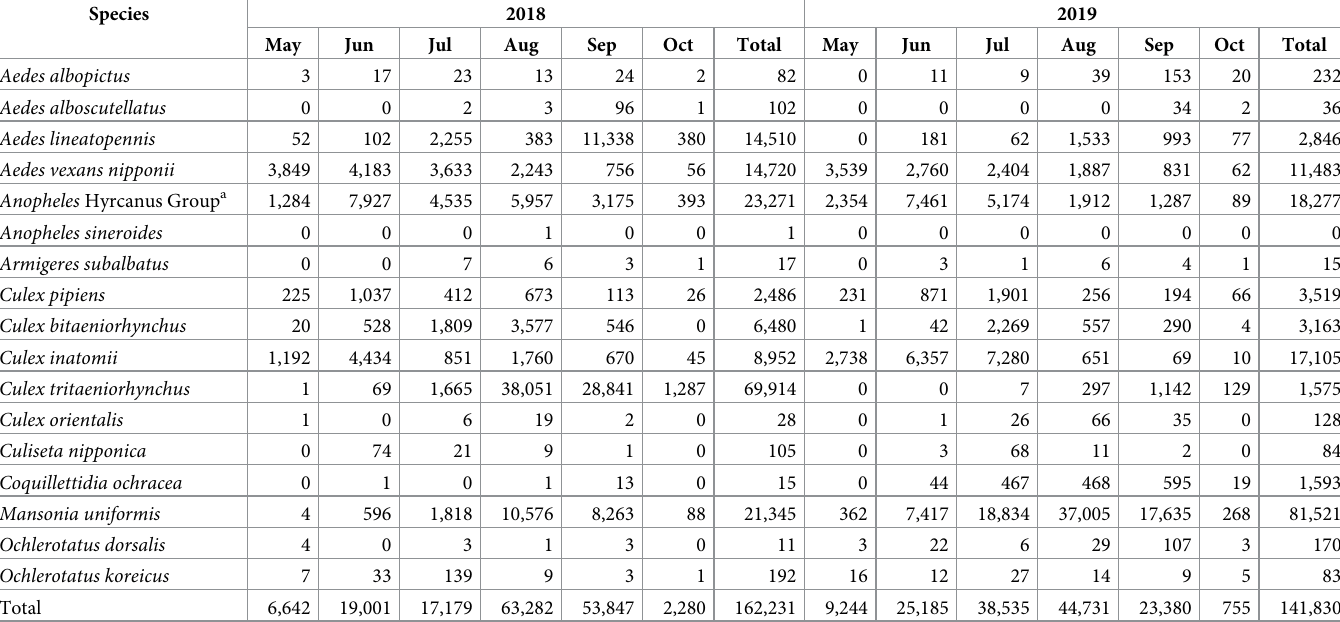
Table 4. Total number of mosquitoes collected, by month, at USAG Humphreys using Independence 1 model Mosquito Magnet 1 traps during 2018 and 2019. Species